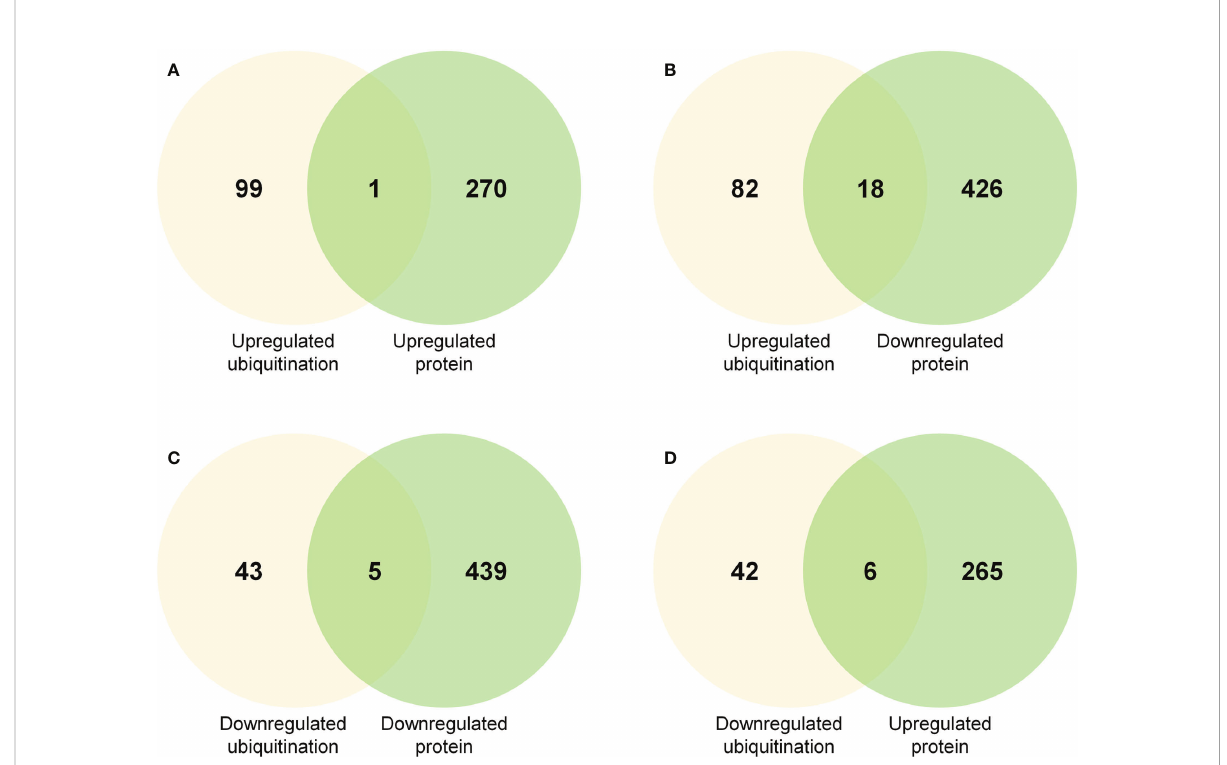
FIGURE 4 Venn diagrams showing common proteins signi fi cantly up- or downregulated in regard to protein abundance and ubiquitination level (A) Common proteins in regard to upregulated protein abundance and upregulated ubiquitination level. (B) Common proteins in regard to downregulated protein abundance and upregulated ubiquitination level. (C) Common proteins in regard to downregulated protein abundance and downregulated ubiquitination level. (D) Common proteins in regard to upregulated protein abundance and downregulated ubiquitination